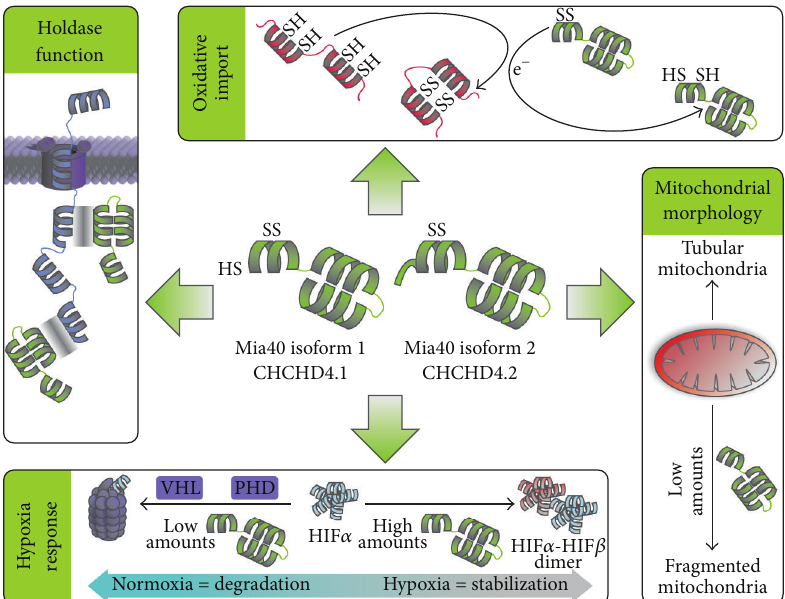
Figure 3: Functions of human Mia40. The protein exists in two different isoforms. Differences in function between the isoforms are not known. Oxidative Import . Mia40 is the main receptor for import and oxidation of twin-CX 9 C and twin-CX 3 C proteins in the IMS. Holdase Function . Mia40 shields hydrophobic patches on proteins imported into the IMS, thus allowing proper folding of these proteins. Mitochondrial Morphology . Reduced amounts of Mia40 lead to increased mitochondrial fission and the formation of a more fragmented mitochondrial network. Hypoxia Response . Under normoxic conditions the protein HIF1 𝛼 is constantly degraded. This degradation is mediated by hydroxylation by prolyl hydroxylase domain enzymes (PHD) and ubiquitination by the Hippel-Lindau E3 ligase (VHL). Upon hypoxia oxygen as substrate of PHD is missing resulting in impaired HIF1 𝛼 degradation and increased stability. If not degraded HIF1 𝛼 can dimerize with constitutively expressed HIF1 𝛽 and induce the hypoxia response. Silencing Mia40 using RNAi prevents stabilization of HIF1 𝛼 under hypoxic conditions. In contrast increased amounts of Mia40 as can also be found in certain tumors result in increased stabilization of HIF1 𝛼